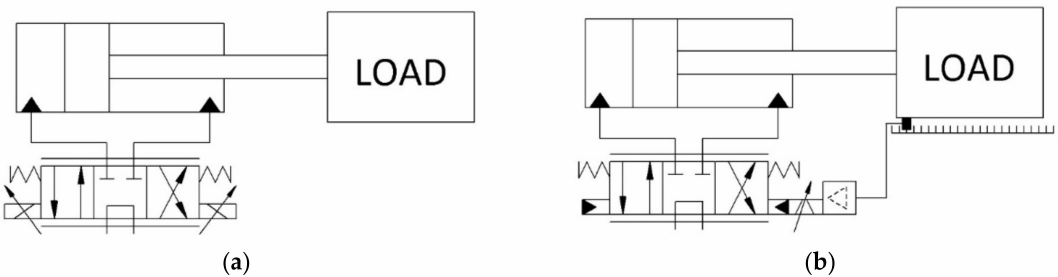
Figure 15. Proportional ( a ) and servo valve ( b ) applications